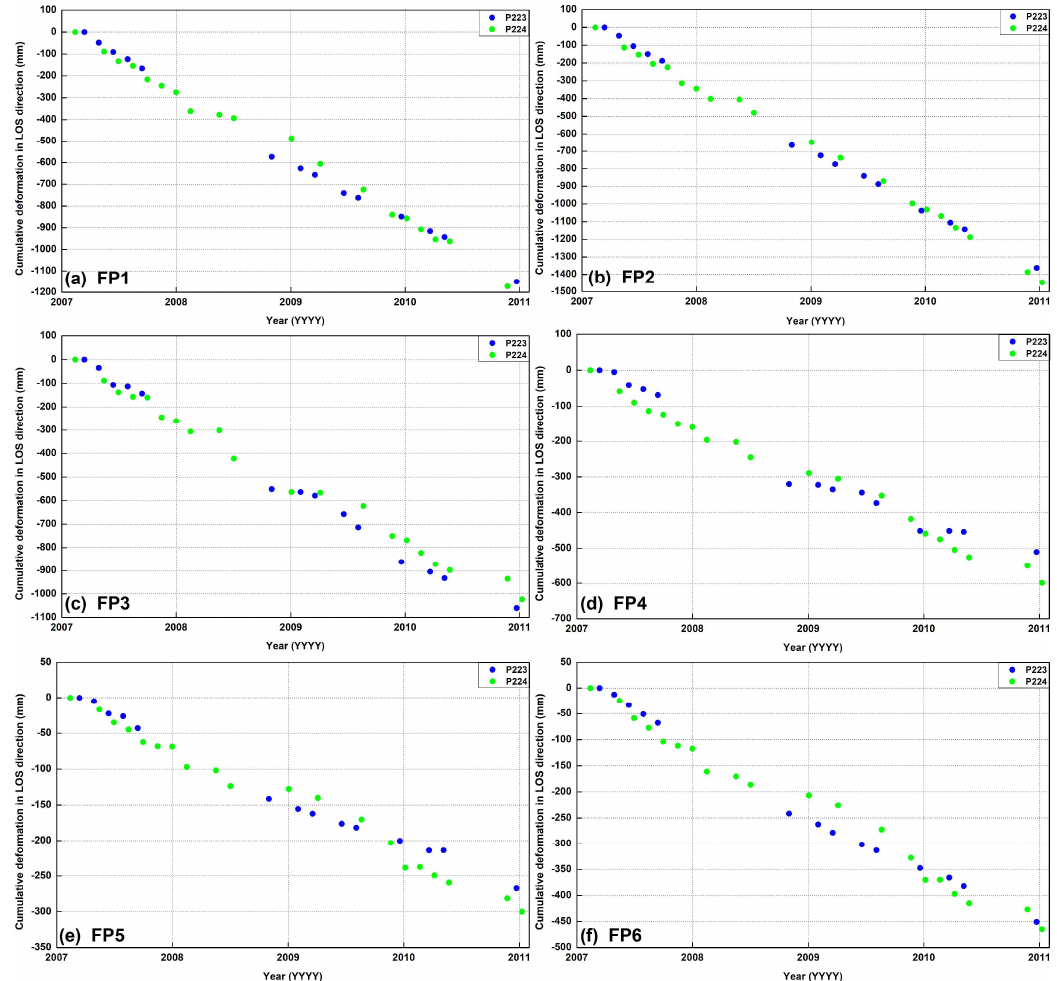
Figure 6. Cumulative deformation along the radar LOS direction for Path 223 (blue dots) and Path 224 (green dots) of six feature points (FP1, FP2, FP3, FP4, FP5, and FP6) as shown in Figure